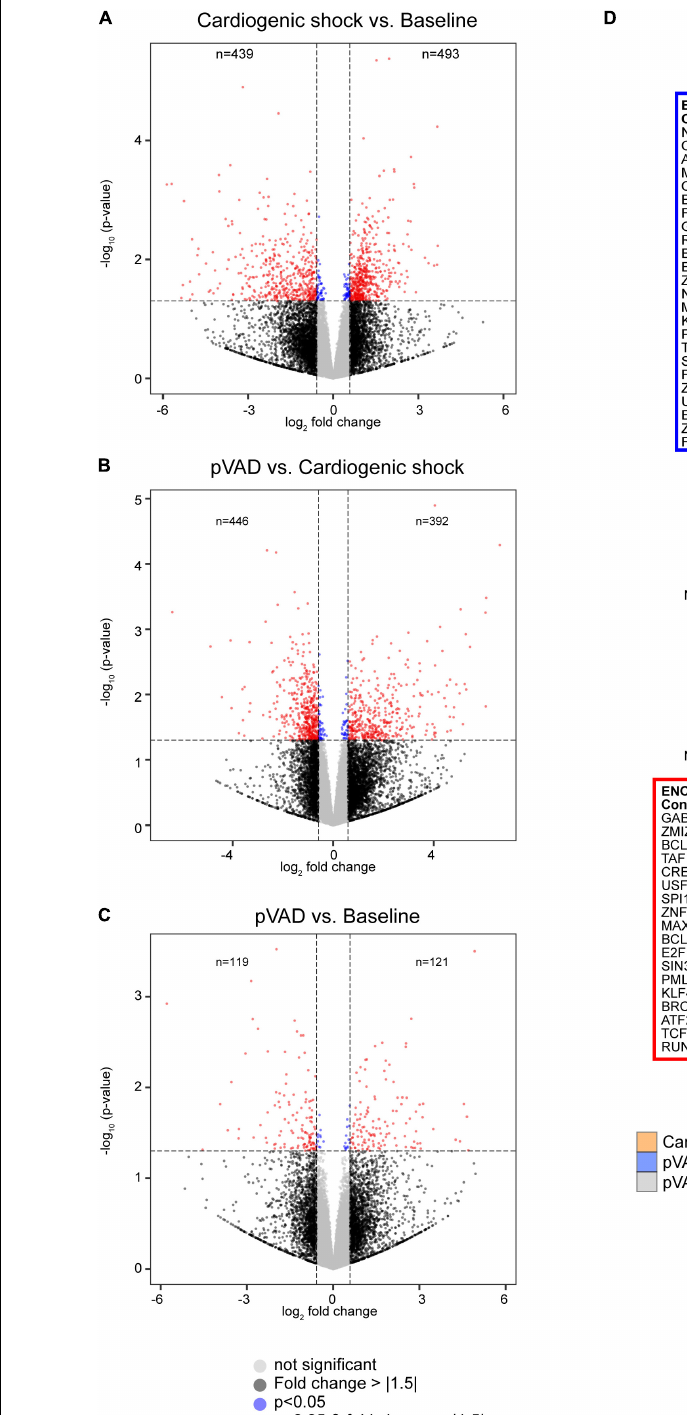
Frontiers in Cardiovascular Medicine |